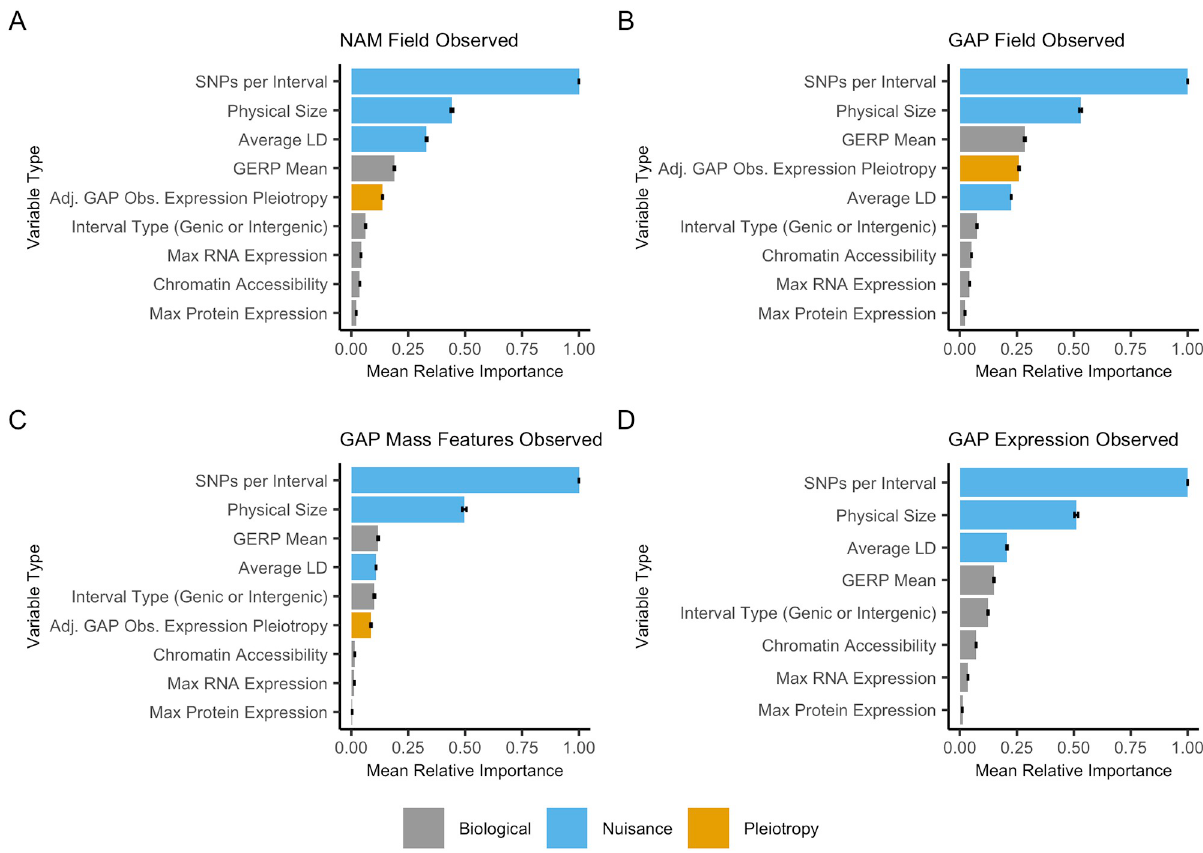
Fig 5. Relative importance scores from random forest models suggest high importance for nuisance terms and low importance for biologically relevant terms in explaining interval-based pleiotropy. The random forest results shown are from Model 2 (with no gene-ontology terms). Across all four population-trait categories, nuisance variables such as the number of input SNPs, interval size, and average linkage-disequilibrium (LD) showed higher relative importance over biological features. The plots show the observed pleiotropy values for (a) NAM field, (b) GAP field, (c) GAP mass features, and (d) GAP expression data. Model 2 results for the permuted data are available in S5 Fig. The bar charts depict the mean relative importance and standard error of each variable from a leave-one-chromosome-out